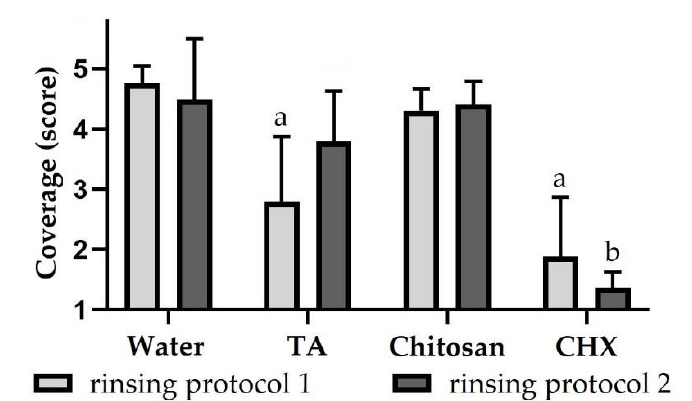
Figure 1. Biofilm coverage (score 1–5) of dentin specimens after rinsing with different rinsing solutions. Subjects carried intraoral splints with specimens for 48 h and rinsed with different experimental solutions. In rinsing protocol 1, rinsing was performed after 3 min, 12 h, 24 h, 36 h and 47.5 h and in rinsing protocol 2 after 3 min, 12 h, 24 h and 36 h. The biofilm formed on specimens was stained with LIVE/DEAD ® Baclight™ and evaluated using a scoring system. The height of the bars corresponds to mean values and the line applied to standard deviations. Friedman test followed by Dunn’s multiple comparison test: significant differences ( p < 0.05) to water are marked with ‘ a ’ for rinsing protocol 1 and with ‘ b ’ for rinsing protocol 2. TA = tannic acid, CHX = chlorhexidine.